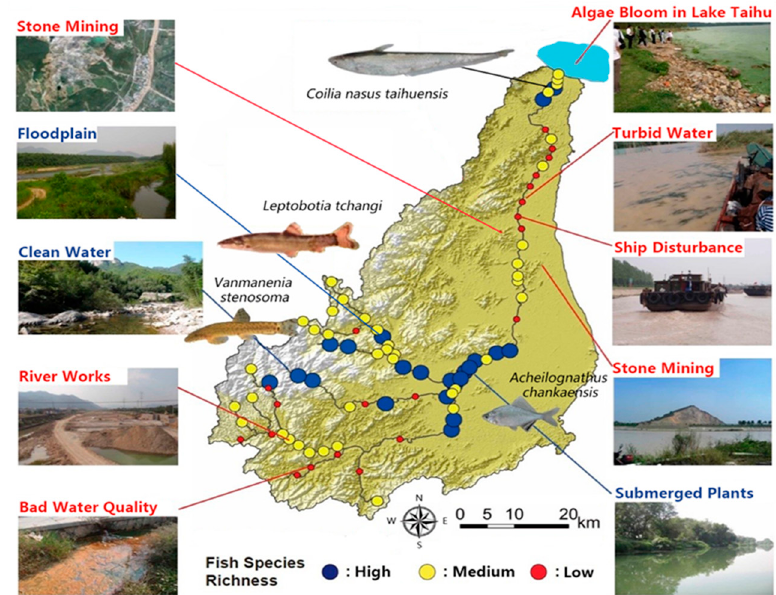
Figure 2. Map of fish biodiversity hotspots and influencing factors for East Tiaoxi River.